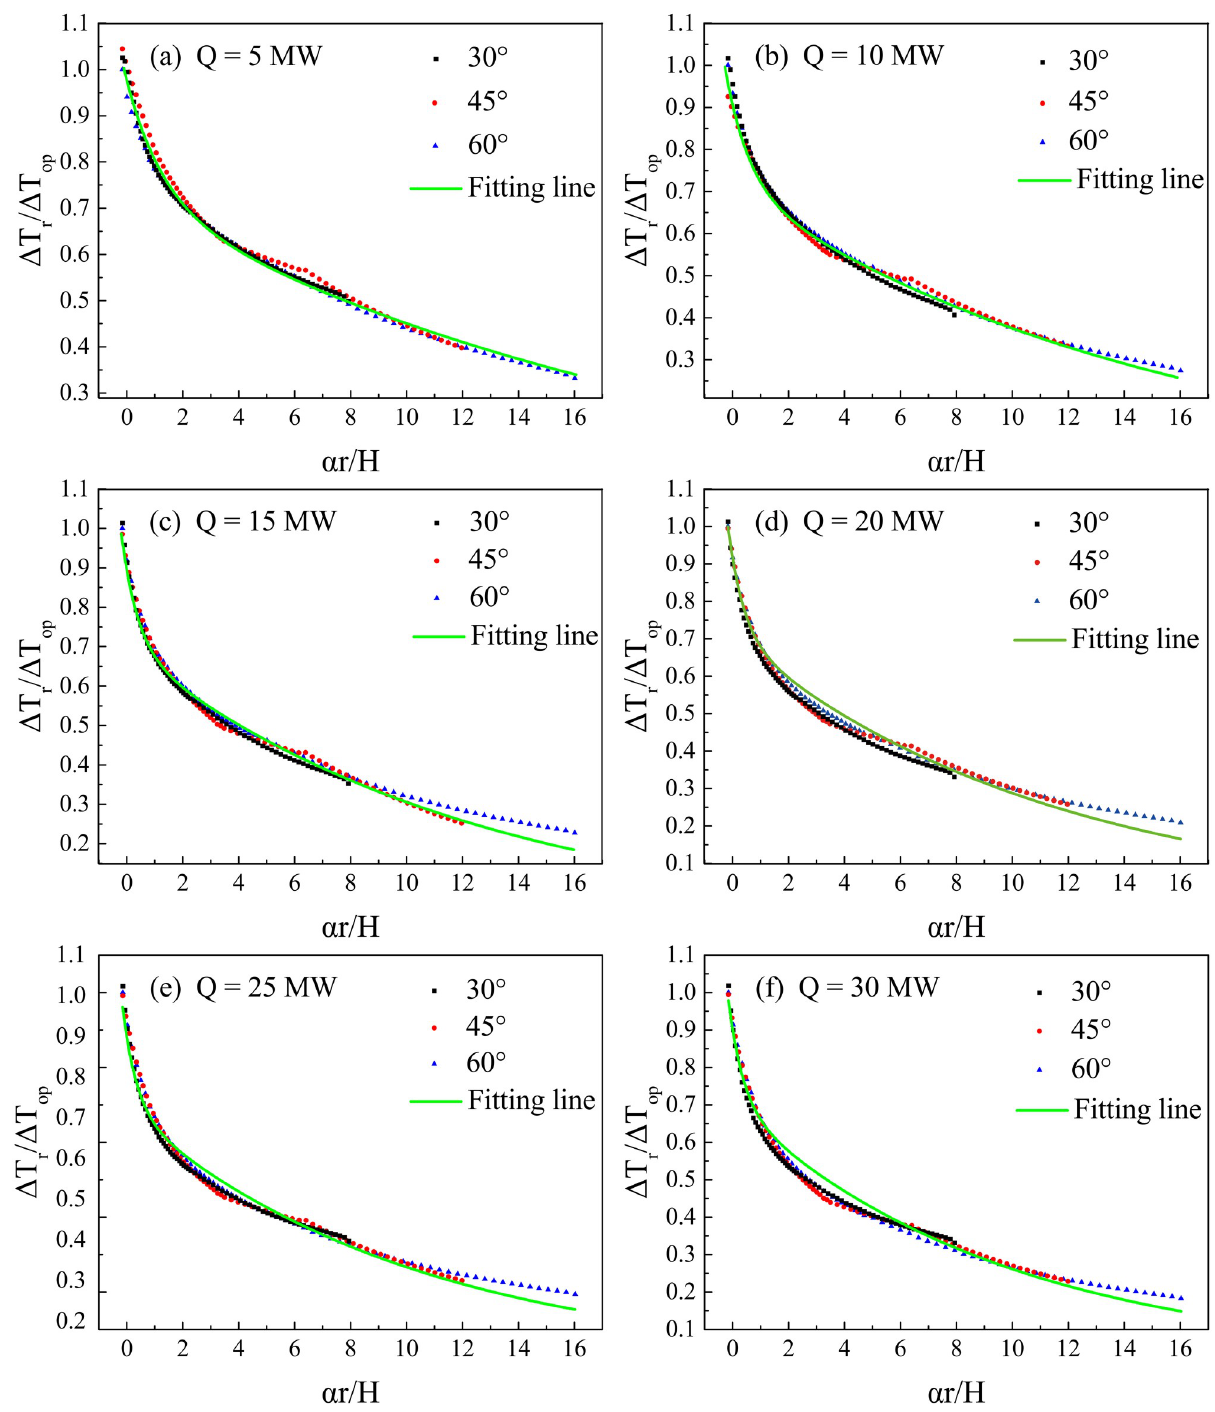
Fig 13. Dimensionless temperature rise ( Δ T r / Δ T op ) against new dimensionless distance ( α r / H ) along longitudinal direction of branch tunnel for various HRRs.